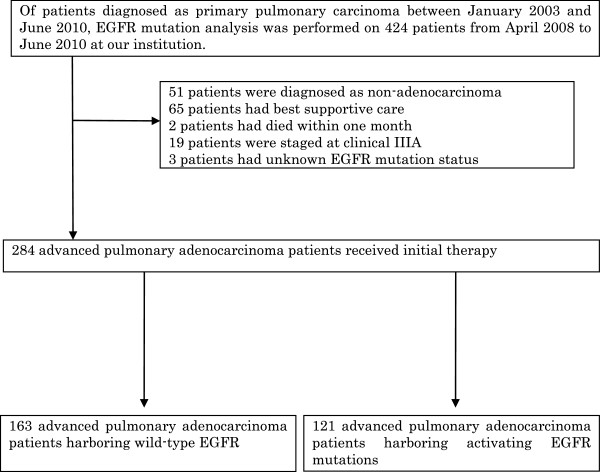
A flow-diagram of the patients included in the analysis.